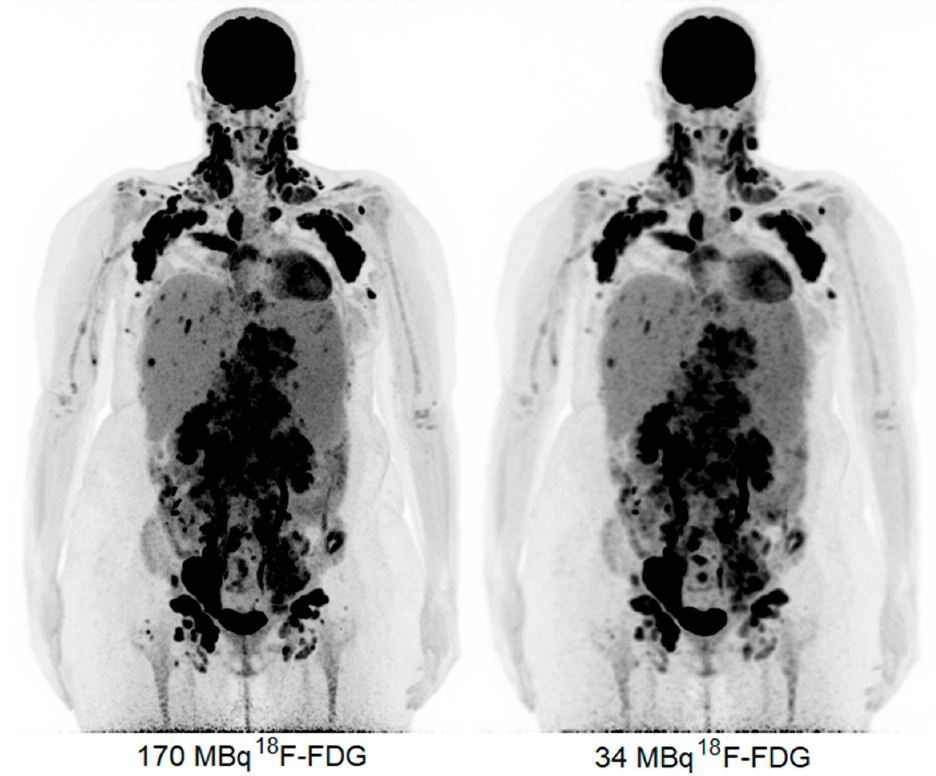
Figure 1. Maximum intensity projection PET images acquired with 170 MBq ( left ) and 34 MBq ( right ).